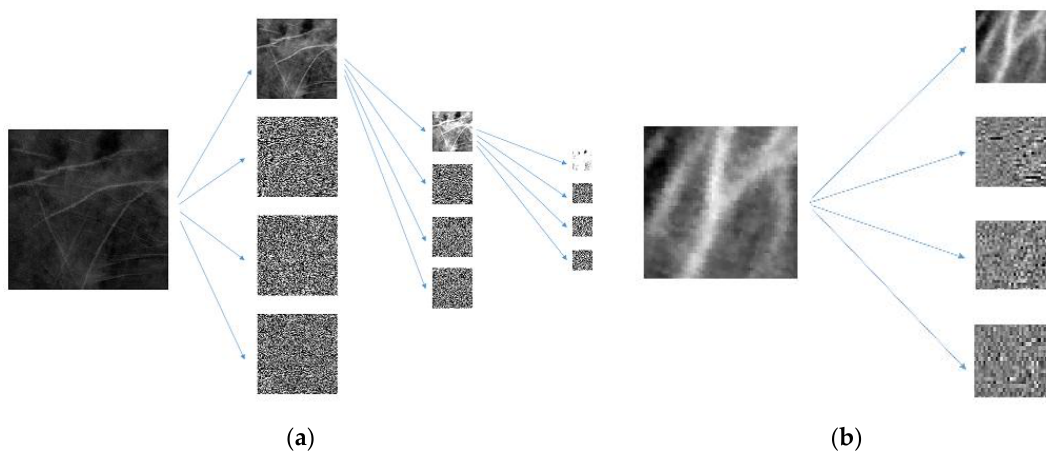
Figure 8. ( a ) Three levels of DWT in palmprint ROI decomposition; ( b ) One level of DWT in vein pattern ROI decomposition. Sensors 2015 , 15 , page–page